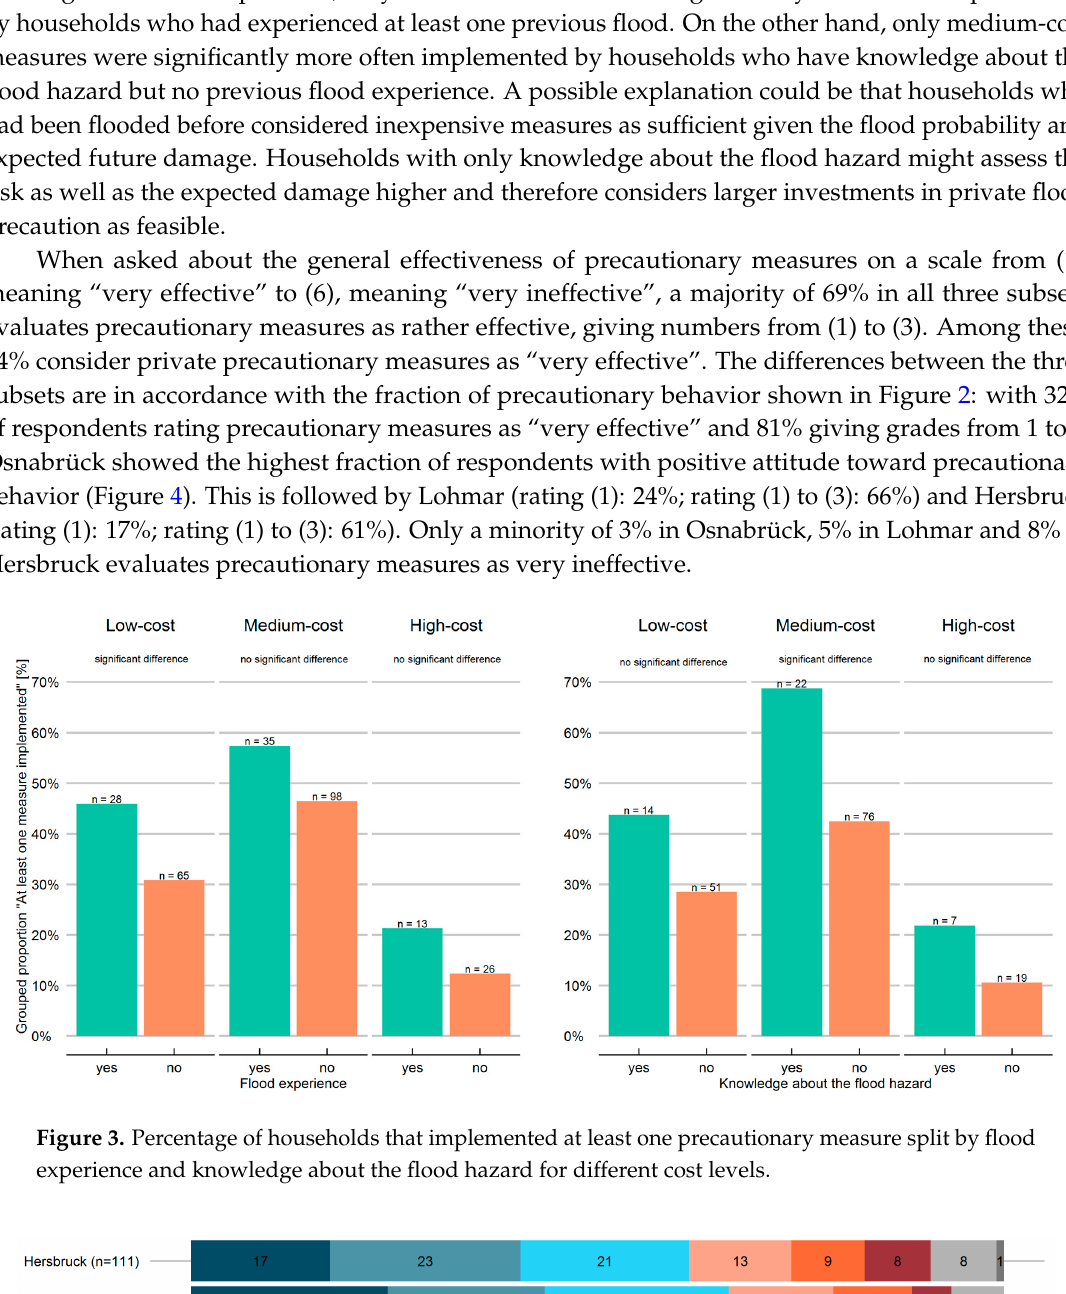
Figure 3. Percentage of households that implemented at least one precautionary measure split by flood experience and knowledge about the flood hazard for different cost levels.